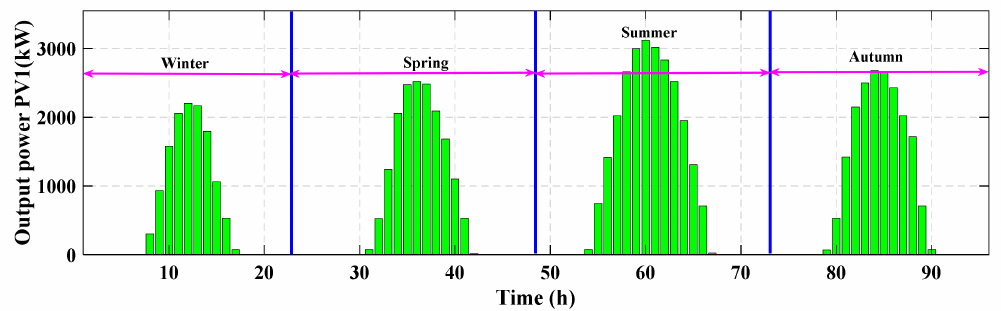
Figure 6. The outputted power from the first unit for case 1.